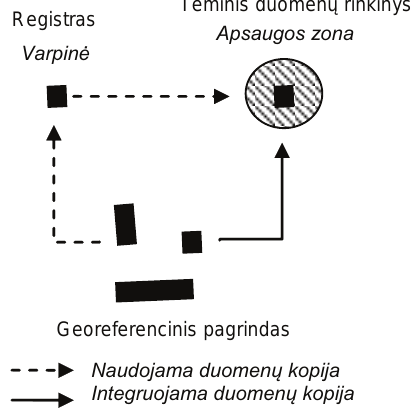
Fig. 1. An example of transferring and using spatial